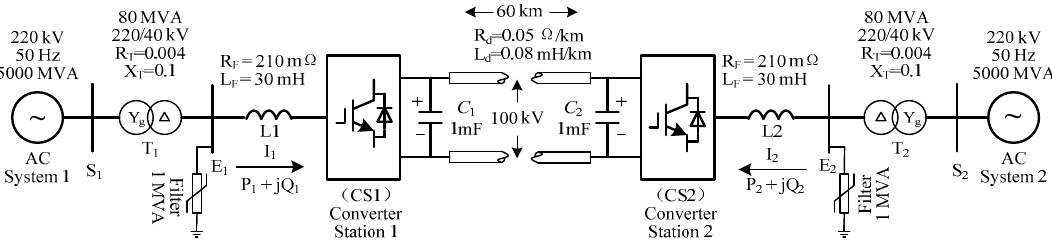
Figure 1. Single-line diagram of the two-terminal voltage source converter high voltage direct current (VSC-HVDC) system studied.